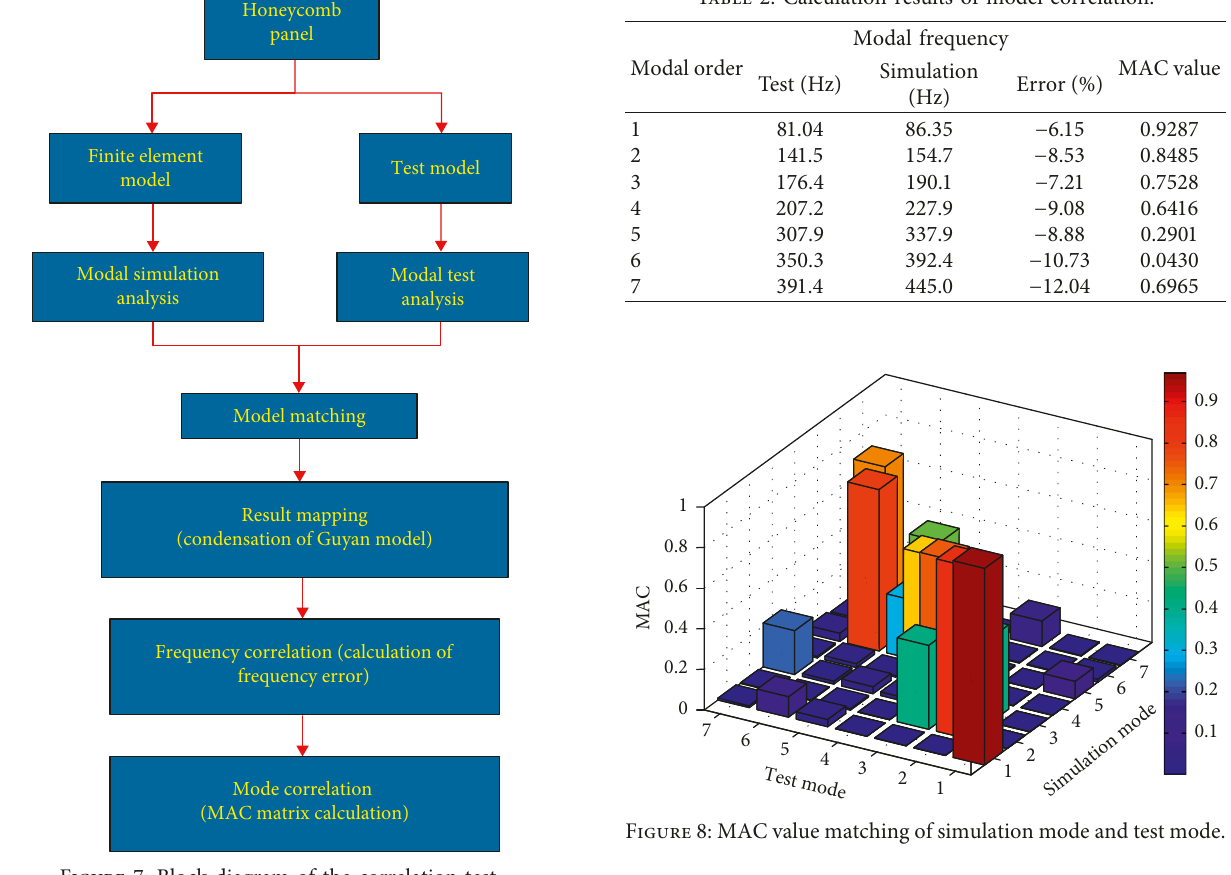
Figure 7: Block diagram of the correlation test.